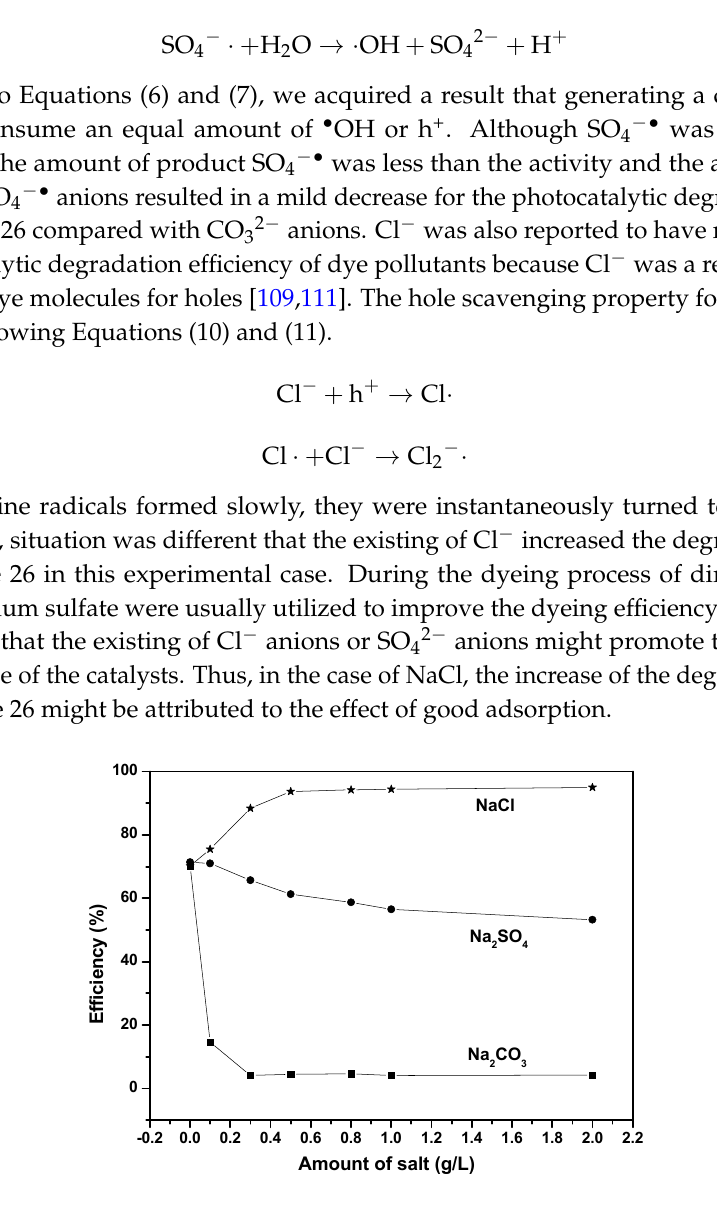
Figure 16. Effect of the coexisting salts on the photocatalytic degradation efficiency of Direct Orange 26.